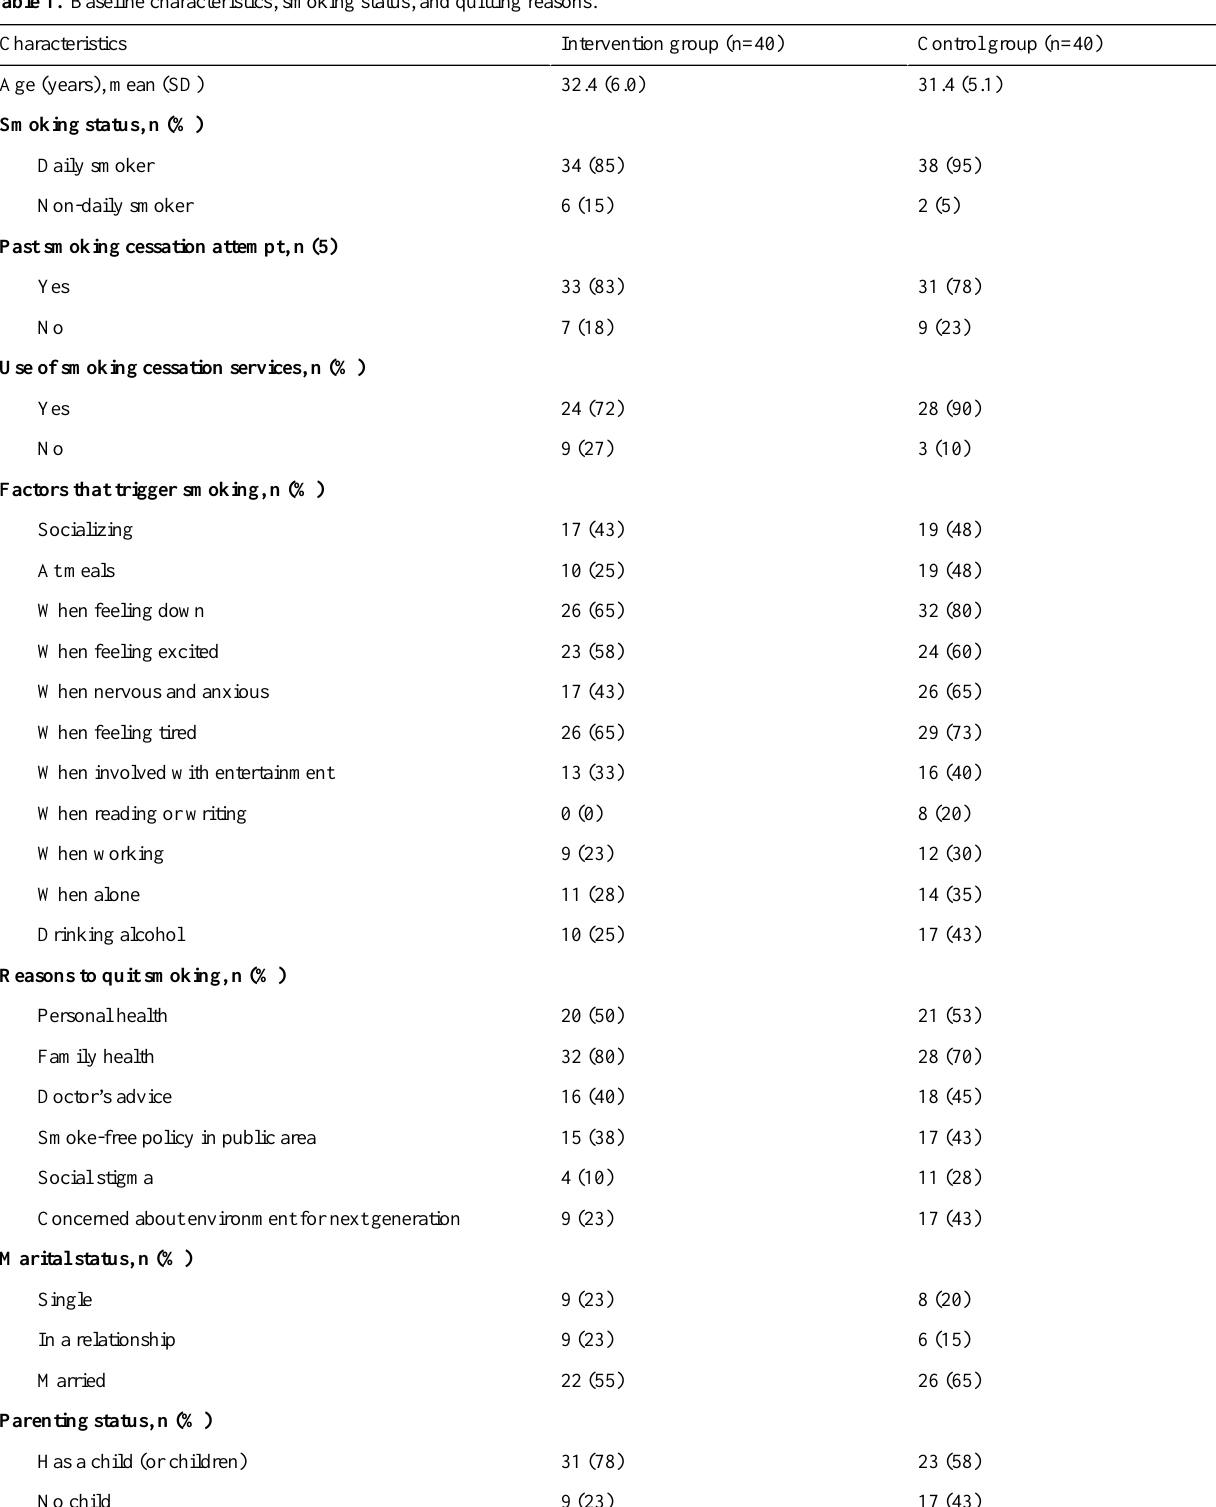
Table 1. Baseline characteristics, smoking status, and quitting reasons.